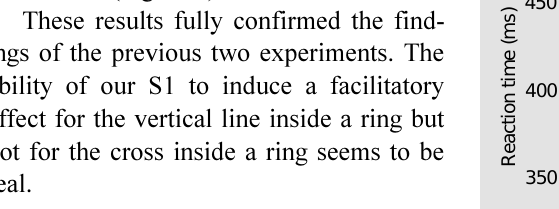
Figure 4. Mean reaction time (± SEM) of 12 participants to the vertical line inside the ring (V) and to the cross inside the ring (V-H) in the first testing session and at the same position as S1 or different ones in the second testing session of Experiment